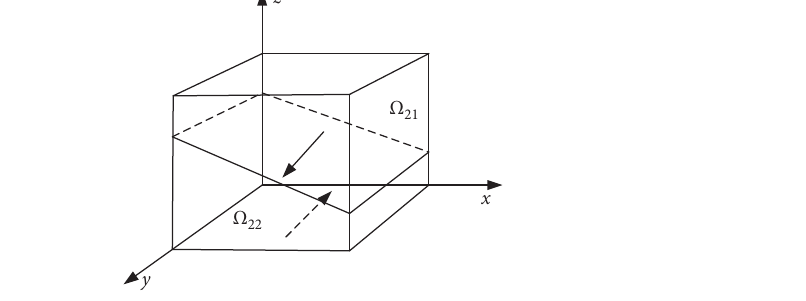
Figure 3: Dynamic evolution of the ESCOs’ decision